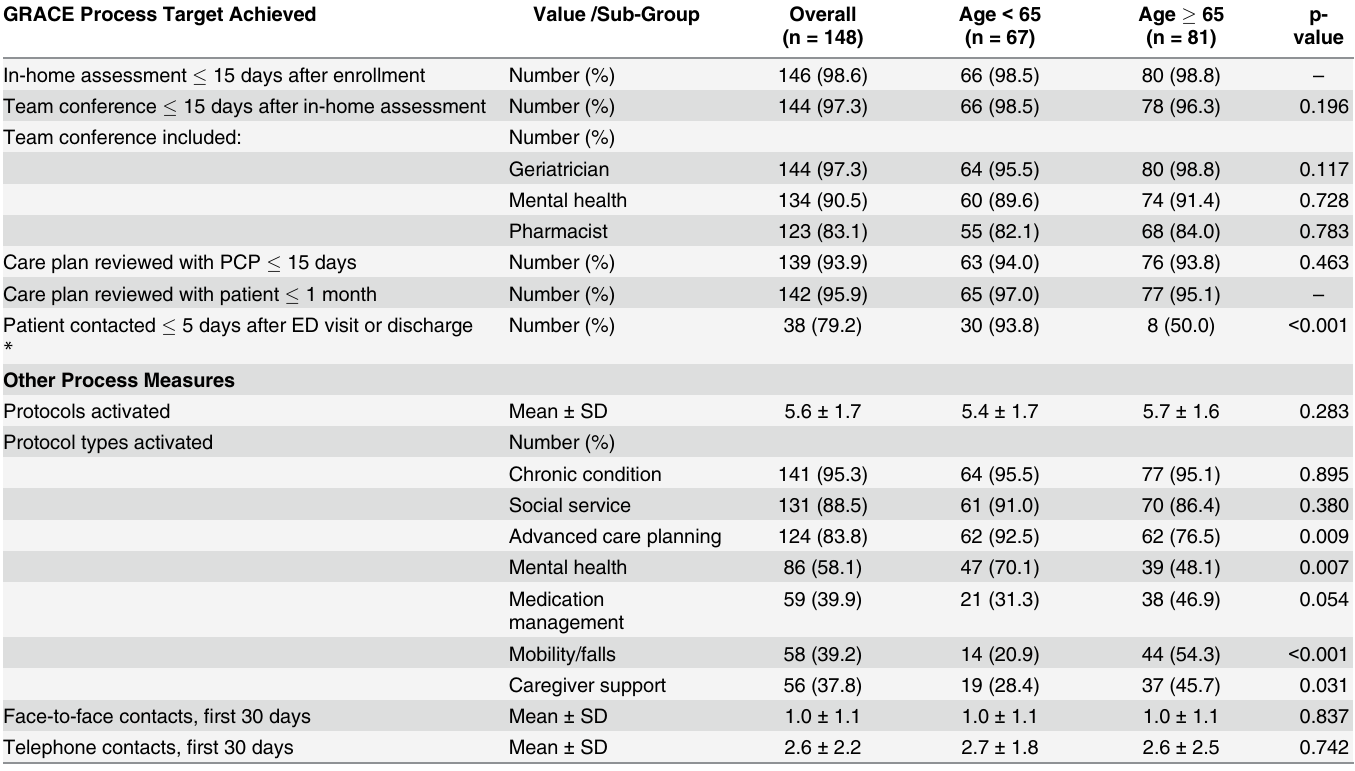
Table 2. Process Measures and Fidelity to GRACE Model.